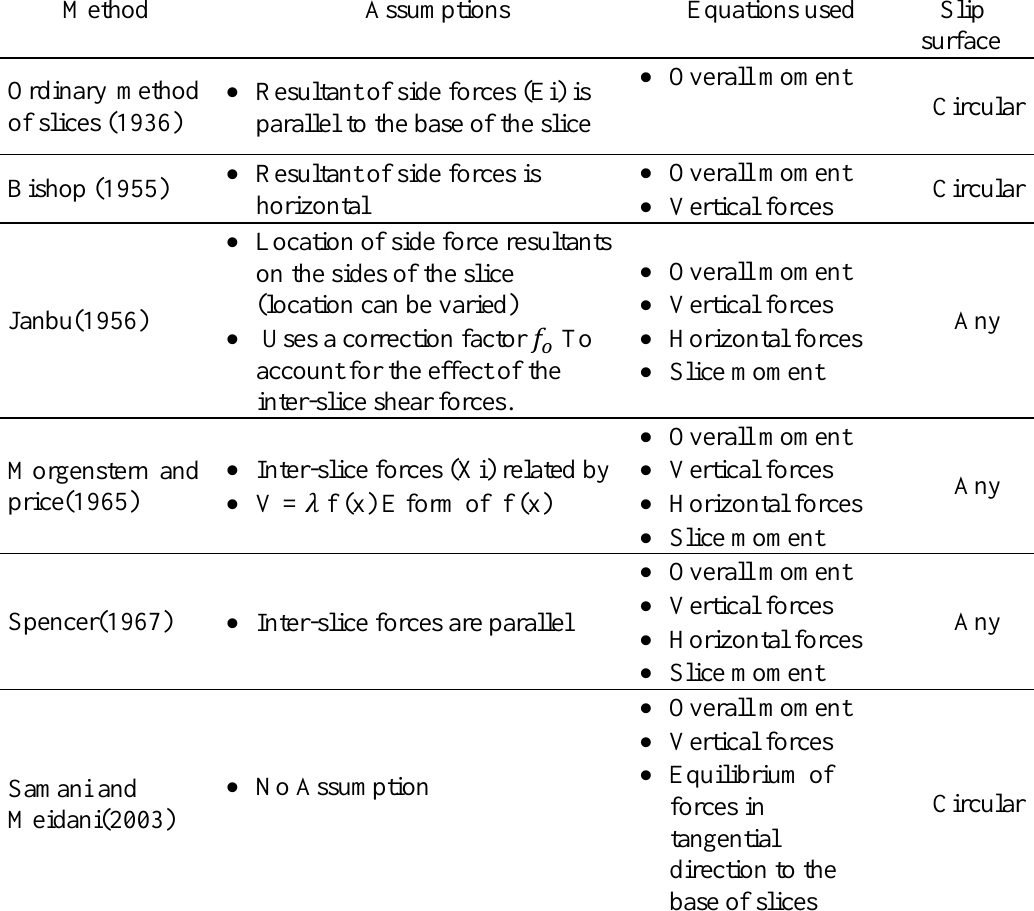
Table 1. Different methods of slices for slope stability